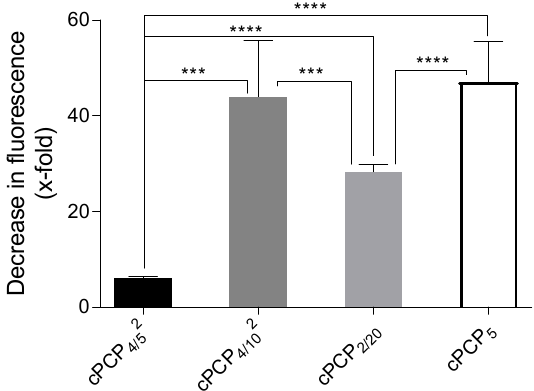
Figure 2. Fluorescence quenching of di ff erent DOX-containing RAFTs. Quenching factor is expressed as a fold decrease in the emission of fluorescence of the analogous compound with respect to free DOX ( n = 9; *** p = 0.0004; **** p < 0.0001; two-way